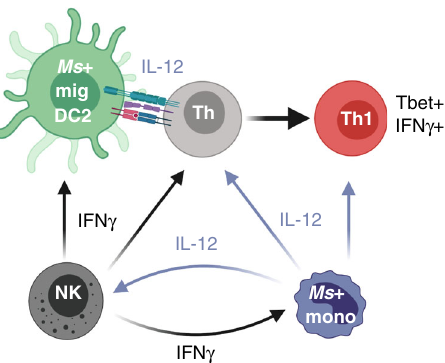
Fig. 6 Monocytes are an essential source of IL-12 for NK cell activation. Diagram illustrating cytokine production by innate cell populations in LN during immunization with Ms . This fi gure was created